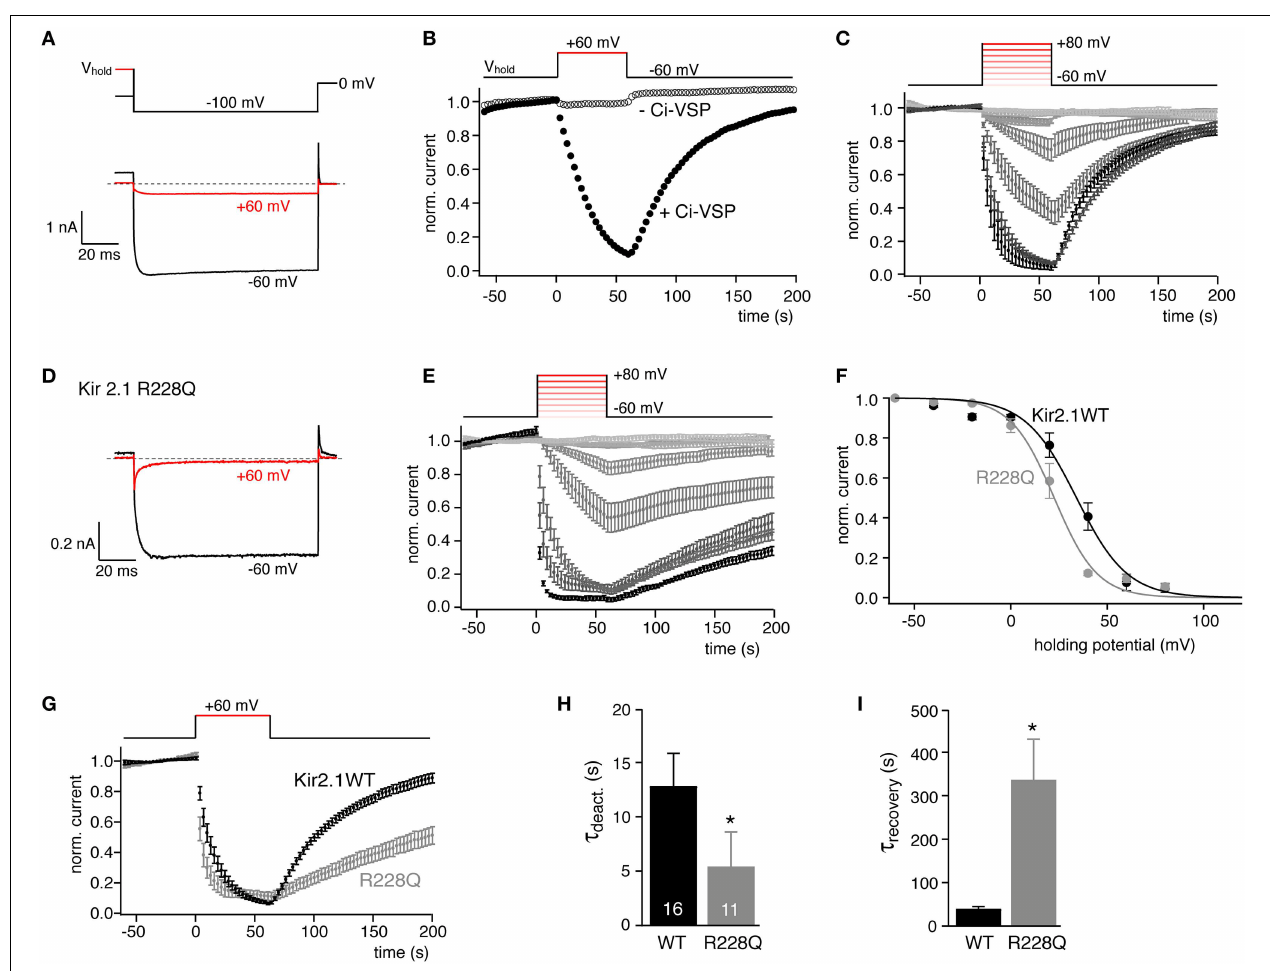
FIGURE 1 | Quantitative determination of the sensitivity of Kir2.1 to activation of Ci-VSP in CHO cells. (A) Representative current recordings from CHO cells co-transfected with Kir2.1 channels and Ci-VSP ( black ). Holding potential was either − 60mV (black) or + 60mV (red) to activate Ci-VSP. Kir2.1 inward currents were evoked by briefly stepping to − 100mV as indicated in the schematic voltage protocol (upper panel). (B) Time course of K + inward currents at − 100mV measured as in (A) when changing holding potential from − 60 to + 60mV as indicated. Channel deactivsation was only observed when Ci-VSP was co-expressed (filled circles), but not in the absence of Ci-VSP (open circles). Currents were normalized to amplitude before switching the holding potential. (C) Current recordings obtained as in (B) . Holding potential was stepped to depolarized potentials between − 40 and + 80mV (20mV increments) as indicated (inset) Ci-VSP was activated at potentials from − 60 to + 80mV with 20mV increments. Data are mean ± SEM from N = 10 –16 cells. (D) Representative currents recordings of cells